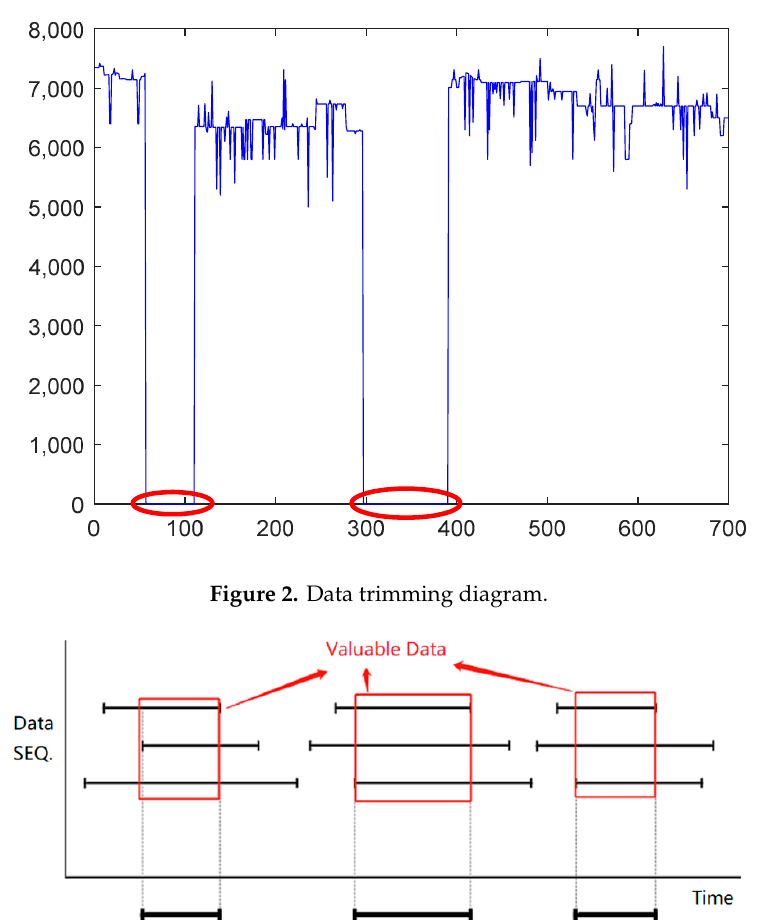
Figure 3. Data synchronization diagram.